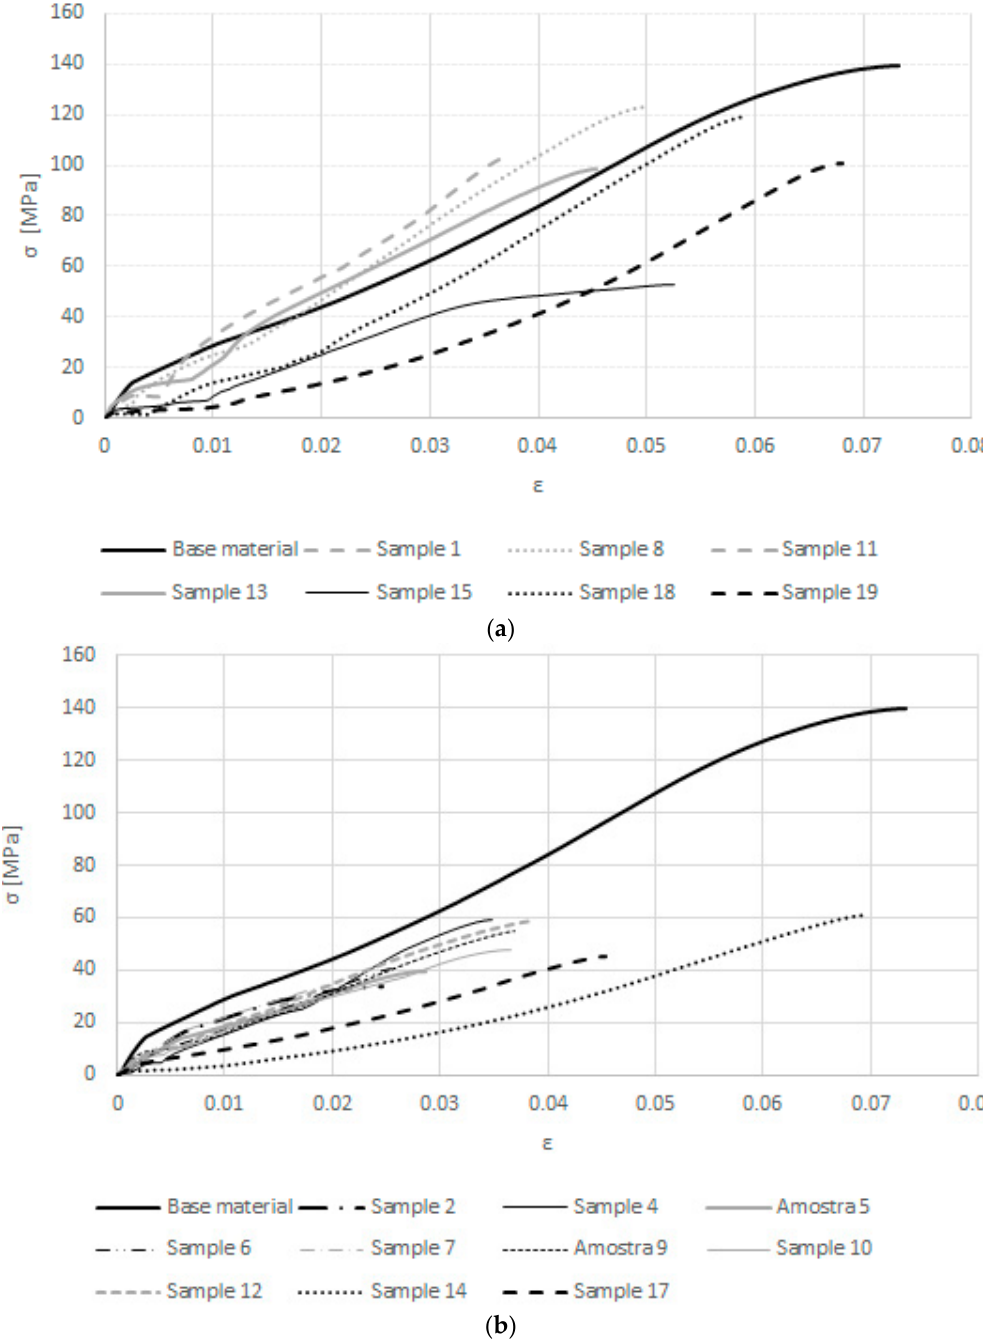
Figure 11. True stress–strain curves for the samples where fracture occurred through: ( a ) the aluminum part; ( b ) the welding joint.